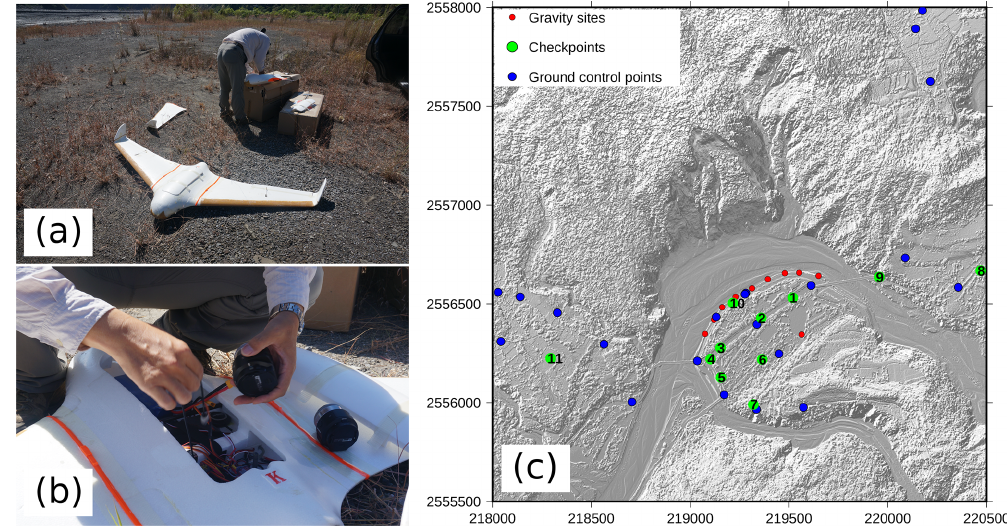
Figure 6. (a) Modified Skywalker X8 UAV. (b) Close-up on the central compartment of the UAV, where the camera and lens are mounted. (c) Map of the ground control points and checkpoints (numbered according to Table 4) with the shaded topography in the background. The gravity sites are also shown for